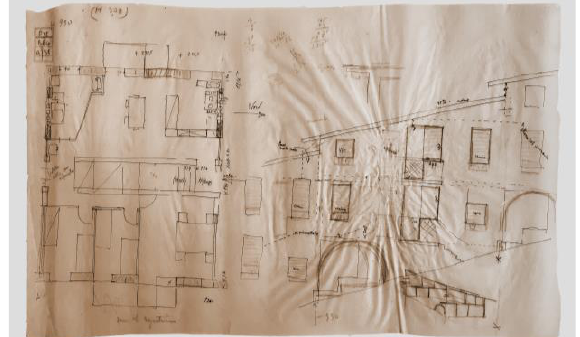
Figure 6. The study of the internal distribution of the apartments (in the version of the sleeping area with three bedrooms) and of the lateral façade with the vaulted cellar